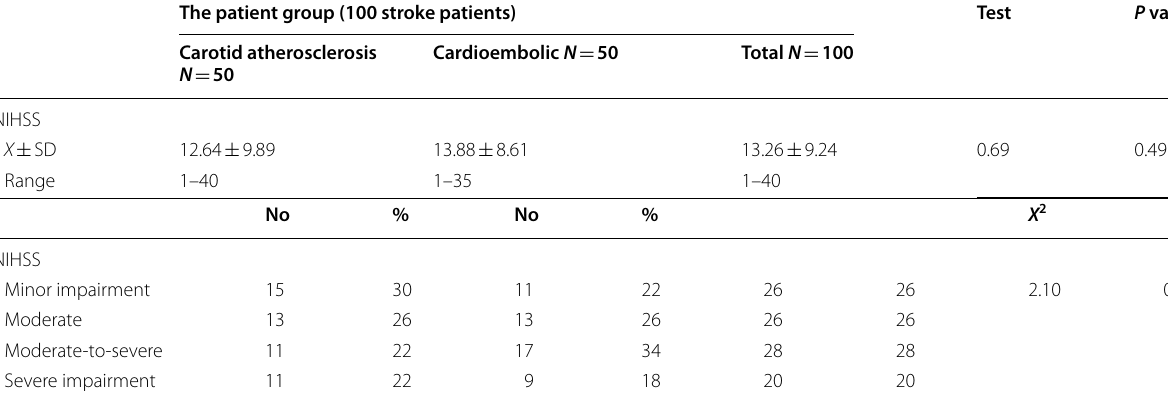
Table 5 National Institutes of Health Stroke Scale (NIHSS) among patients group